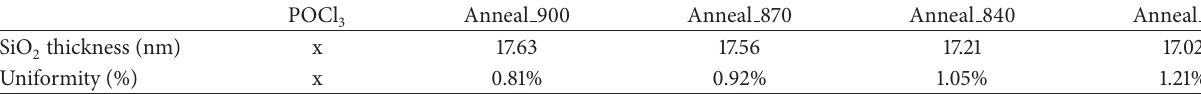
thickness and uniformity. 2